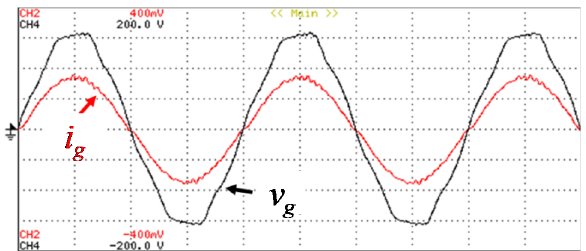
Figure 23. Experimental results during the MF-EVCS operation in R2G mode combined with G2V mode: Ac-side voltage ( v g : 50 V/div); Total home current ( i g : 10 A/div).